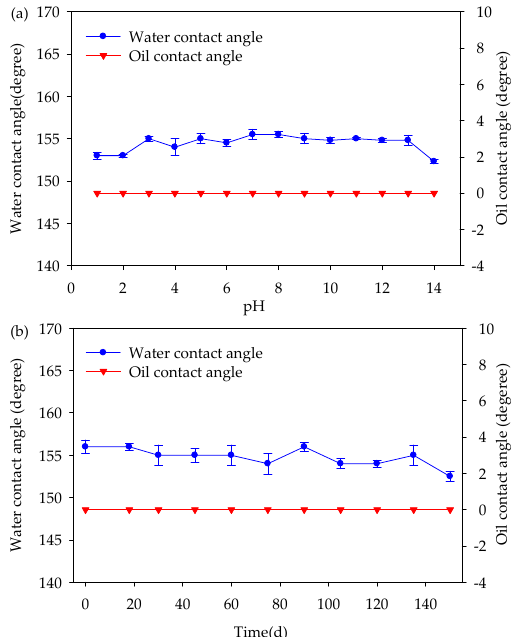
Figure 7. ( a ) The contact angles of the superhydrophobic/superoleophilic wood flour with different pHs of aqueous solution; ( b ) the contact angles of the superhydrophobic/superoleophilic wood flour for the storage evaluation in an ambient environment.